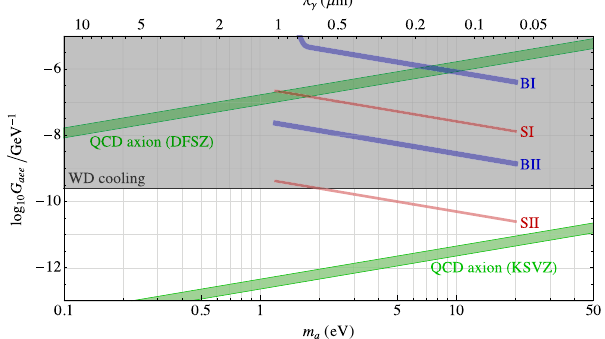
FIG. 13. Reach for the pseudoscalar coupling G as a function of pseudoscalar mass m configurations (thick blue bands) and the SI and II configurations (thin red bands). The green bands indicate the predicted coupling in two benchmark QCD axion models, namely, DFSZ (top) and KSVZ (bottom). The gray exclusion region is excluded by indirect determinations of white dwarf cooling